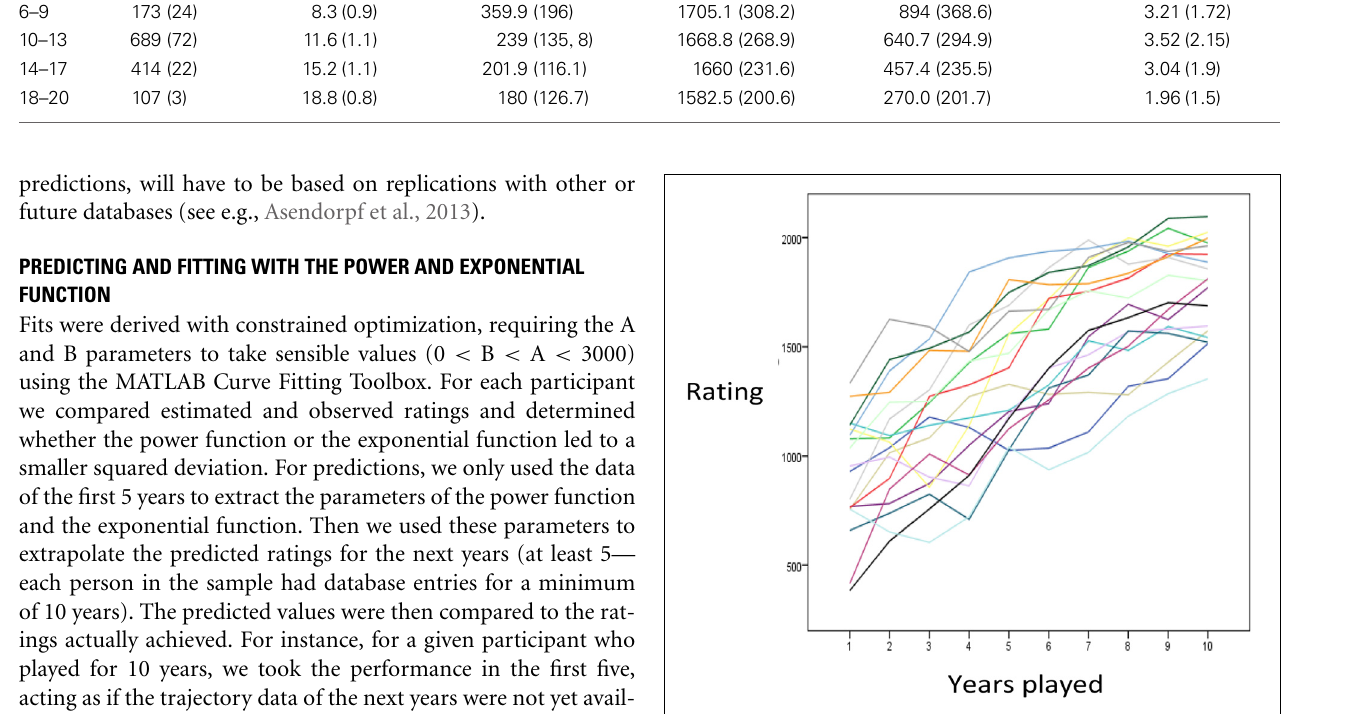
FIGURE 2 | A random sample of individual time